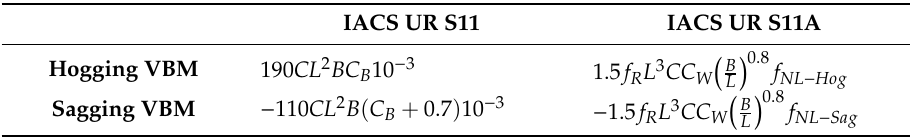
Table 1. Comparison of VBM rule load formulae according to IACS ( L = ship length; B = ship breadth; C B = ship block coe ffi cient; C W : water plane area coe ffi cient; f R = operational factor typically taken as 0.85 [28], C = ship length dependent wave parameter.